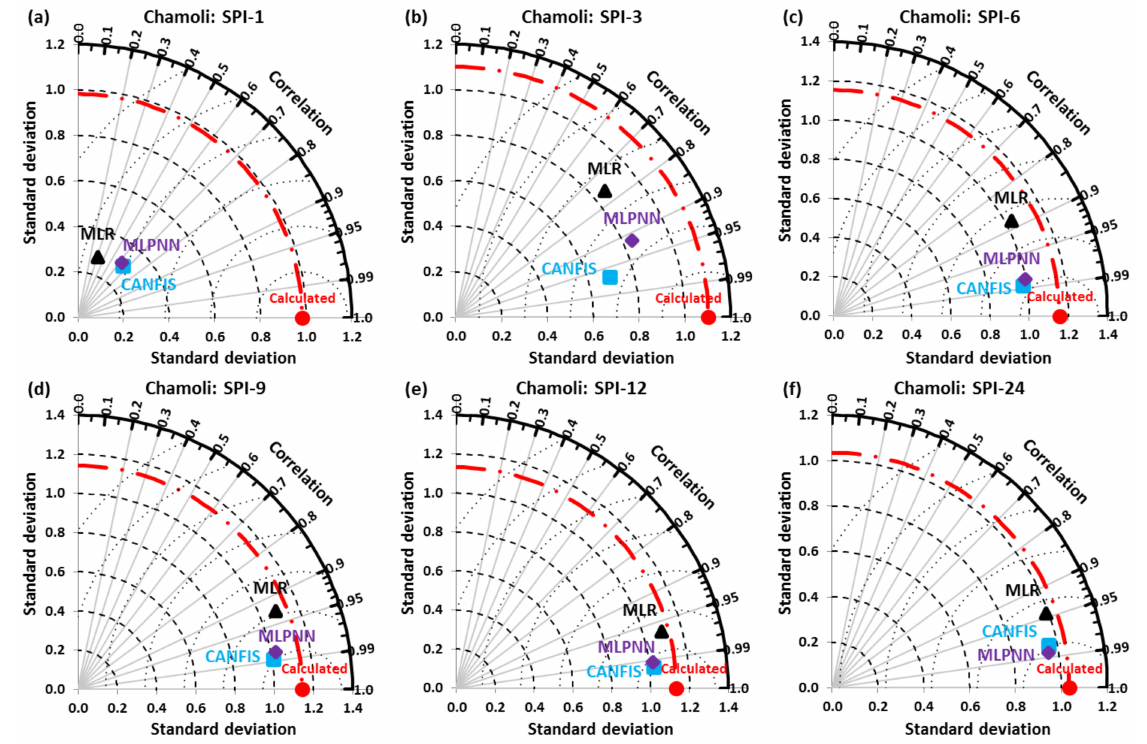
Figure 11. ( a – f ) Taylor diagram of predicted and calculated multi-scalar SPI at Chamoli station.